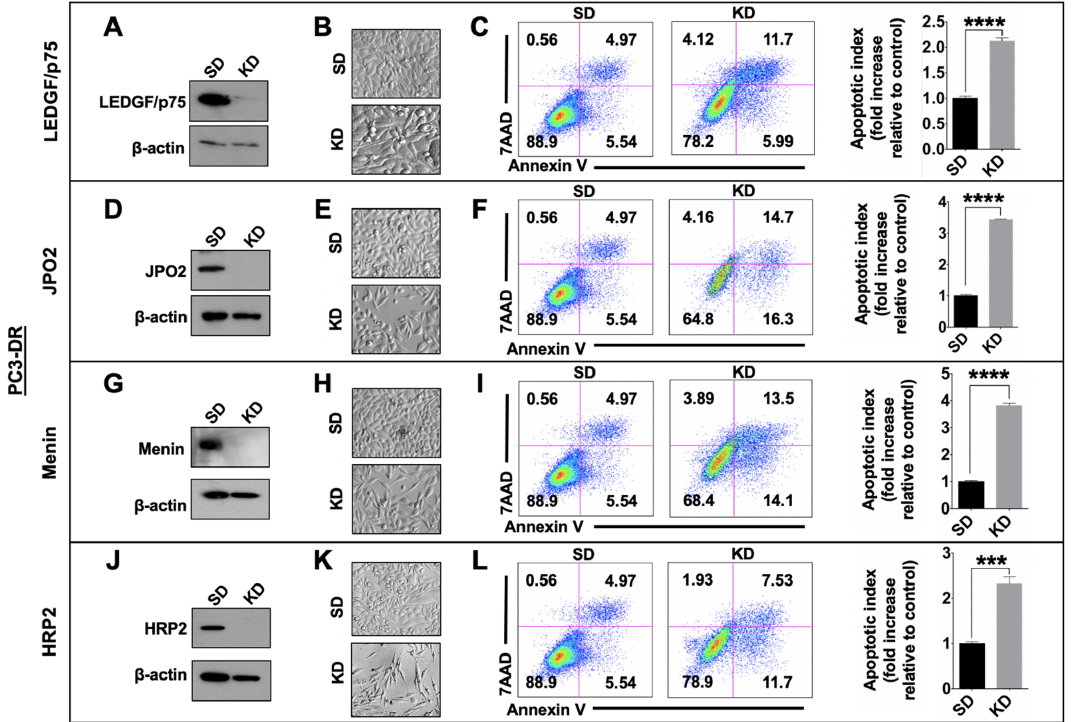
Figure 7. Transient knockdown of LEDGF/p75, JPO2, menin, or HRP2 decreases the survival of PC3-DR cells. siRNA- mediated silencing of LEDGF/p75 ( A ), JPO2 ( D ), menin ( G ), and HRP2 ( J ) was confirmed by immunoblotting of PC3-DR cell lysates transfected with specific siRNAs (KD) or si-SD control oligos for 72 h. PC3-DR cell morphology was visualized by Hofmann Modulation Contrast microscopy ( B , E , H , K ). PC3-DR cells transfected with either control (SD) or specific siRNAs (KD) were stained with Annexin V/7AAD, and cell death was analyzed by flow cytometry ( C , F , I , L ). Representative plots from three replicate experiments showing apoptotic index (calculated as described in Materials and Methods) are presented. Statistical significance was determined by comparing the fold increase in apoptotic cells from cells with LEDGF/p75, JPO2, menin, or HRP2 knockdown with the normalized values for cells transfected with SD control oligos, using Student’s t -test (*** p < 0.001, **** p <